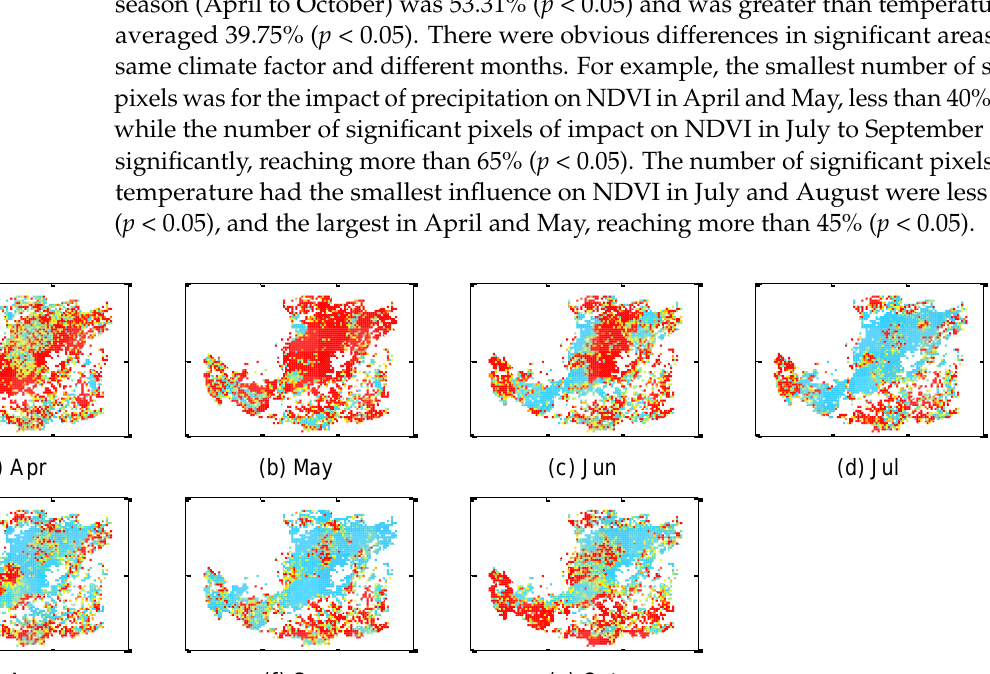
Figure 12. Average values of the lag patterns detected by method 4. ( a ) Precipitation; ( b ) temperature; I—Mixed Forest; II—Grassland; III—Barren or Sparse Vegetation.